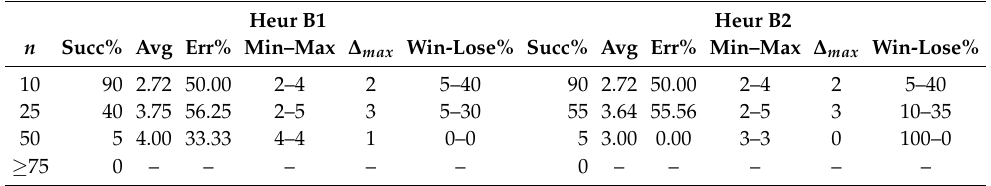
Table 2. Experimental results of Heuristics B1 and B2 on random instances. Heur B1 Heur B2